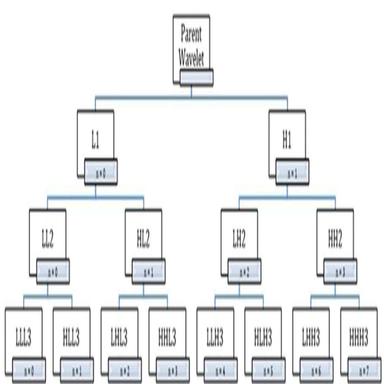
Wavelet Packet Tree representing L – Low Frequency (Approximation) and H – High Frequency (Detail).